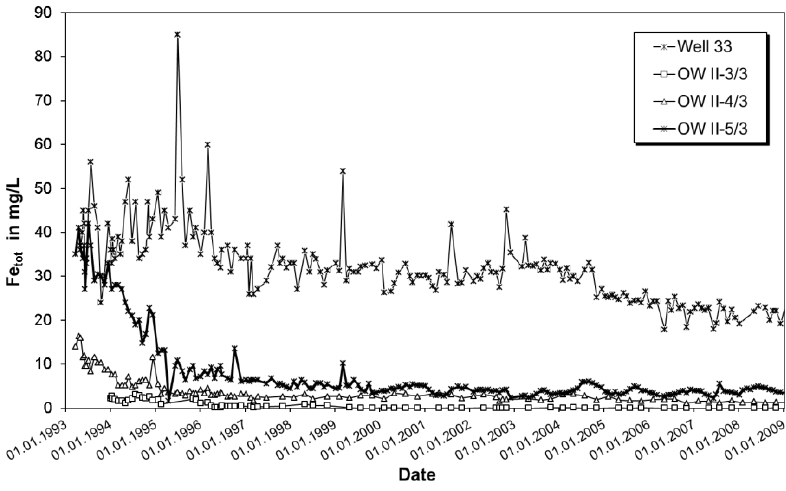
Figure 10. Progression of total iron concentrations in mg/L, medium depth, and cross-section II in Torgau.